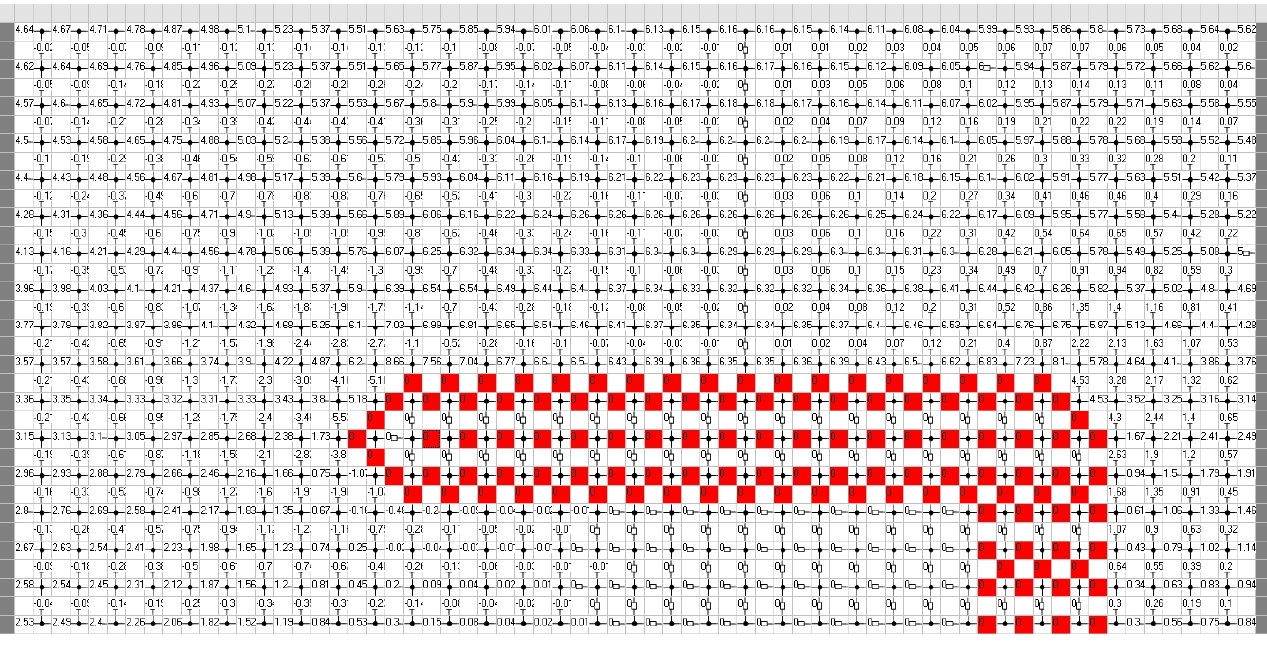
Table 10. ResModel trim simulation